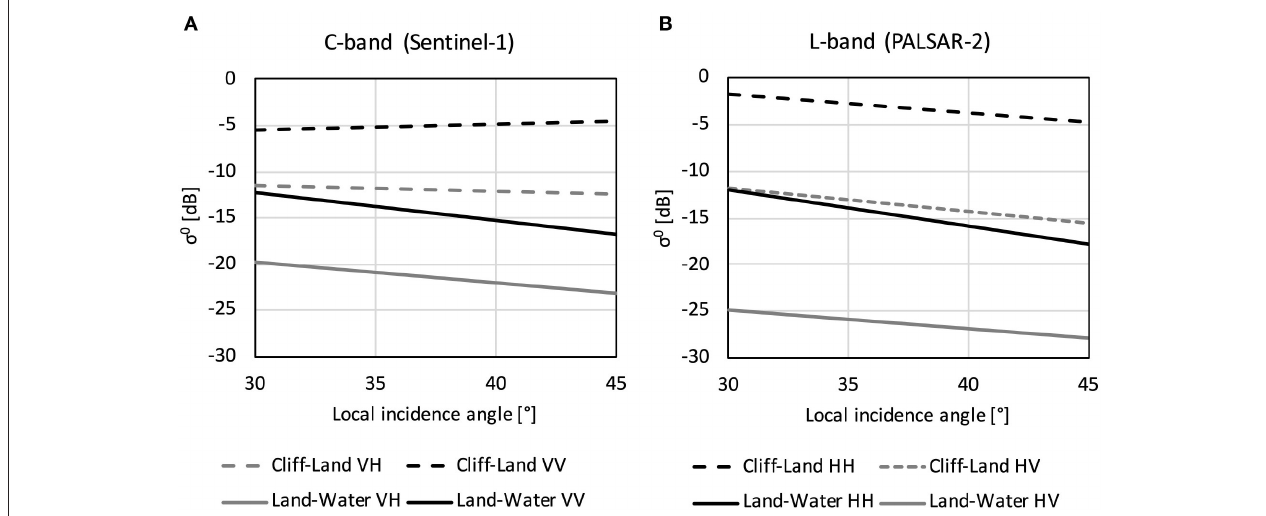
FIGURE 7 | Threshold functions derived for (A) C-band (Sentinel-1, Interferometric Wide Swath mode) and (B) L-band (PALSAR-2, Fine Beam mode). Local incidence angles (x-axis) are derived with respect to the ellipsoid. For equation parameters see Table 3 .